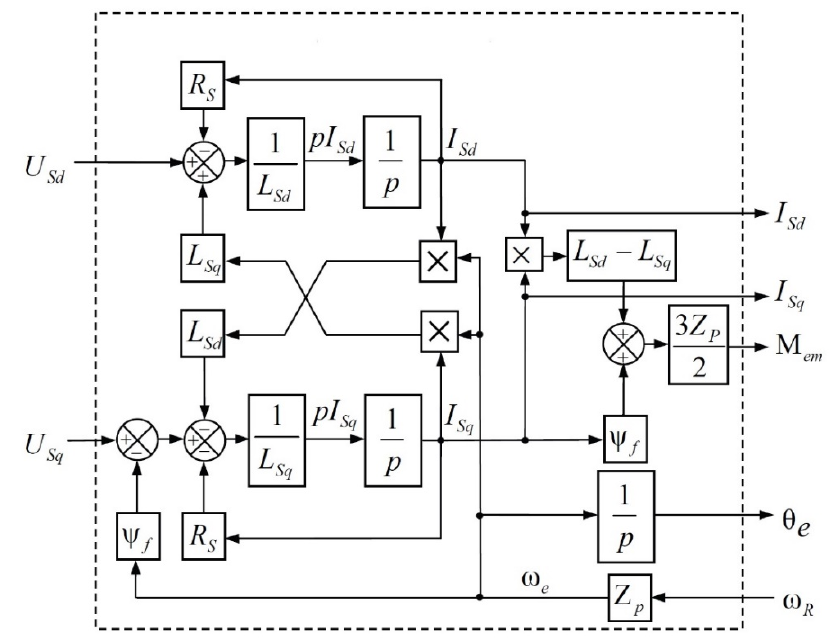
Figure 2. Model of electromagnetic processes of the synchronous motor [14]. The model is augmented with a rotor field angle calculator ( θ e ), which is obtained by integrating the field velocity ( ω e ). The input signals of the model are voltages and velocity, and the output signals are currents, electromagnetic moment and field angle.